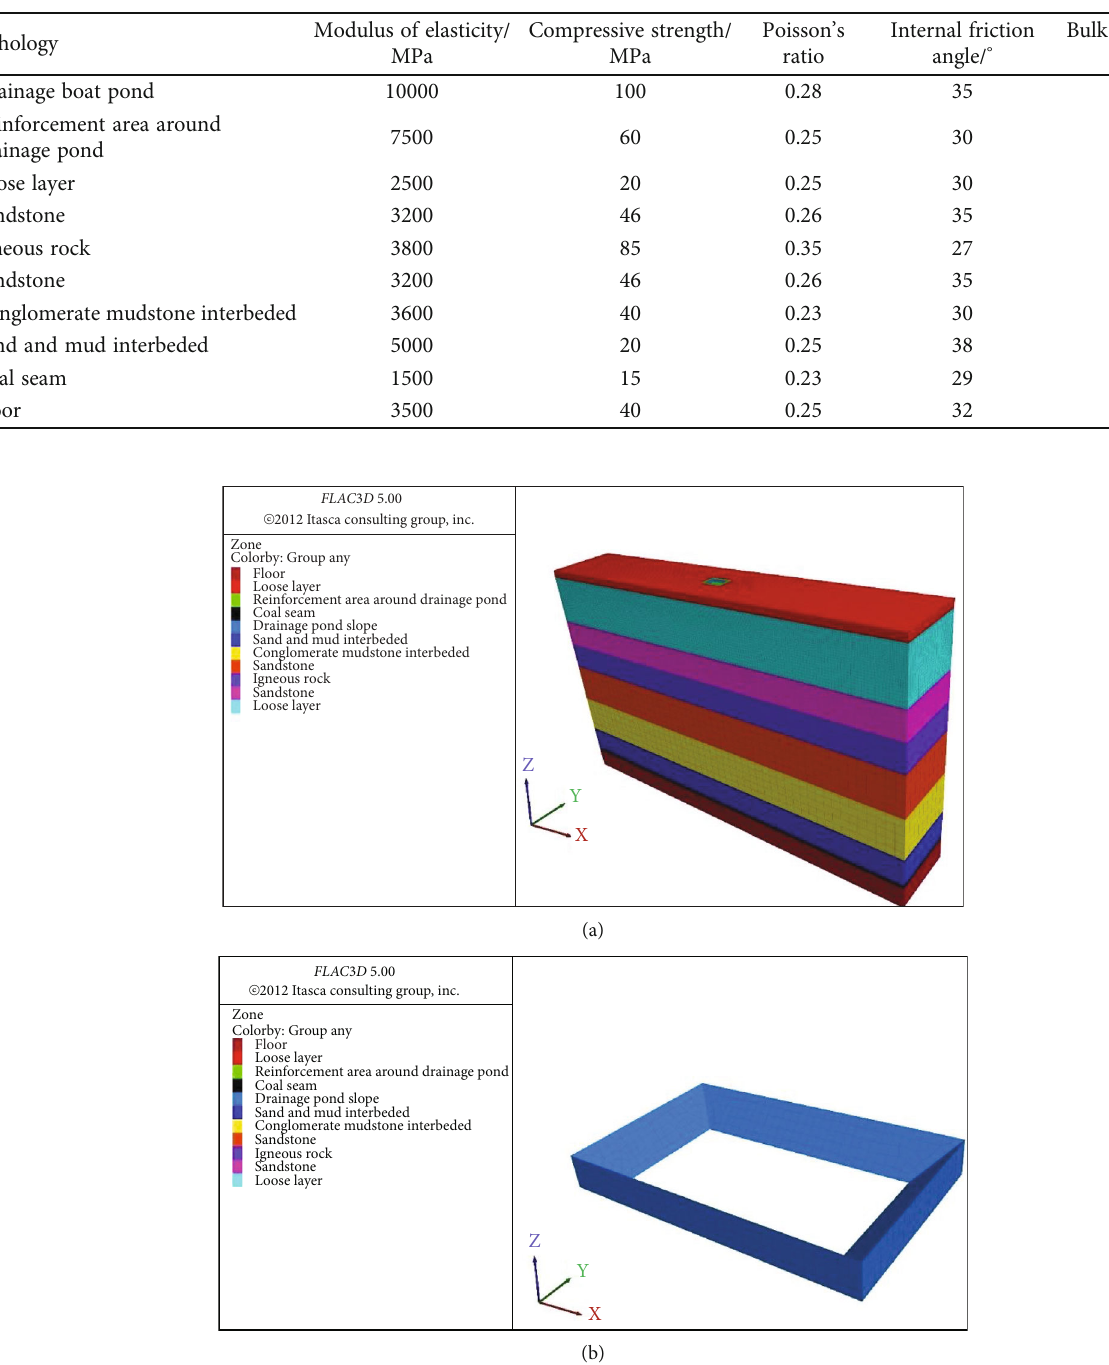
Table 2: Physical and mechanical parameters of strata in 11301#